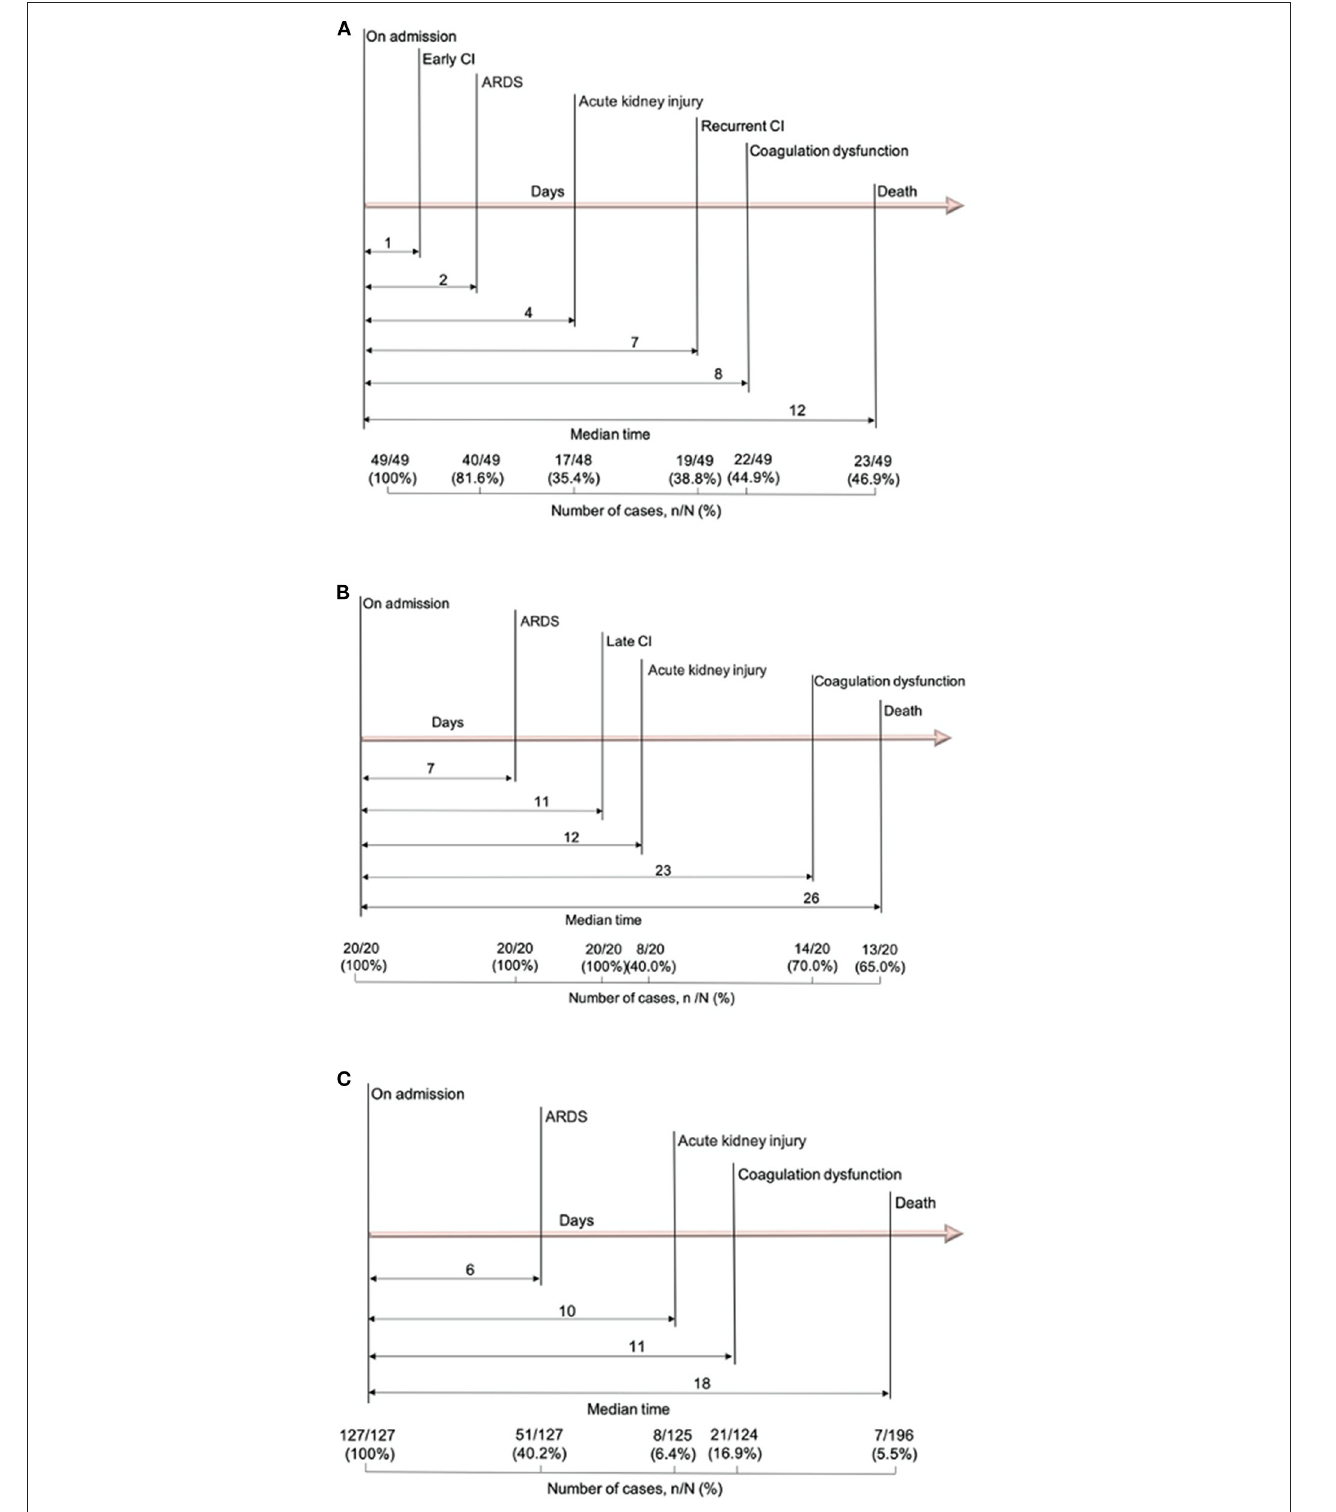
FIGURE 1 | Timeline of COVID-19 patients after admission. (A) Timeline of COVID-19 patients with early CI; (B) Timeline of COVID-19 patients with late CI; (C) Timeline of COVID-19 patients without CI. COVID-19, coronavirus disease 2019; CI, cardiac injury.